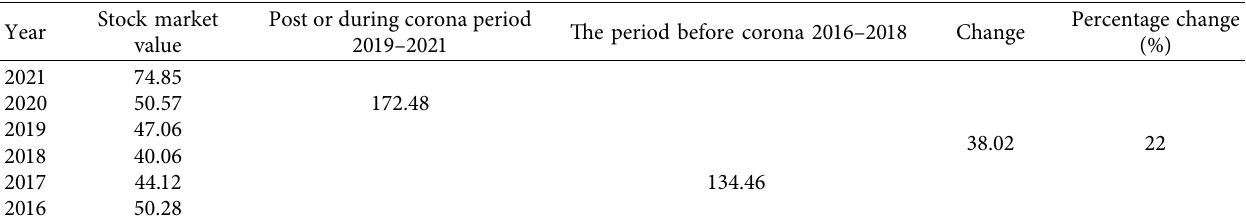
Table 5: Te development of the stock market value of the study sample companies before and after the efects of the Corona pandemic. Year value